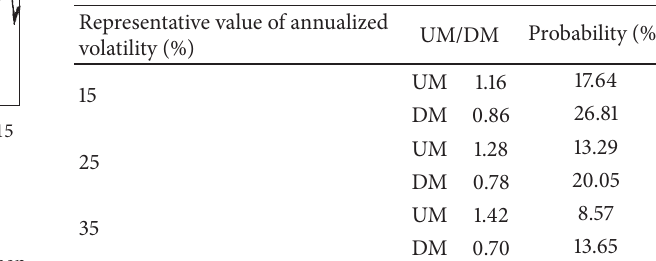
Table 5: The multiples and their corresponding probabilities of representative value of annualized